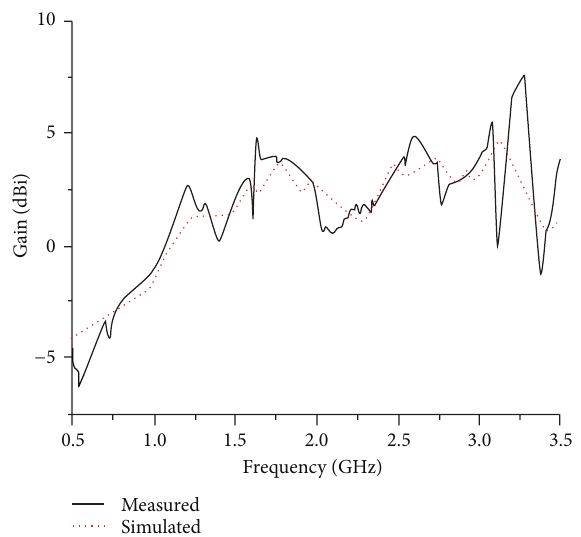
Figure 8: Simulated and measured gain of the proposed antenna.